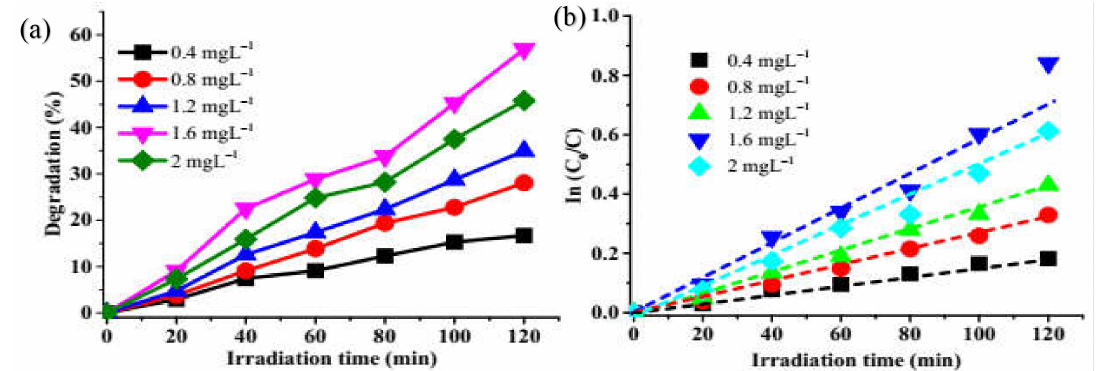
Figure 5. Effect of CuS 1 catalytic dosage against crystal violet ( a ) and the corresponding plot of In(C 0 /C) versus irradiation time ( b